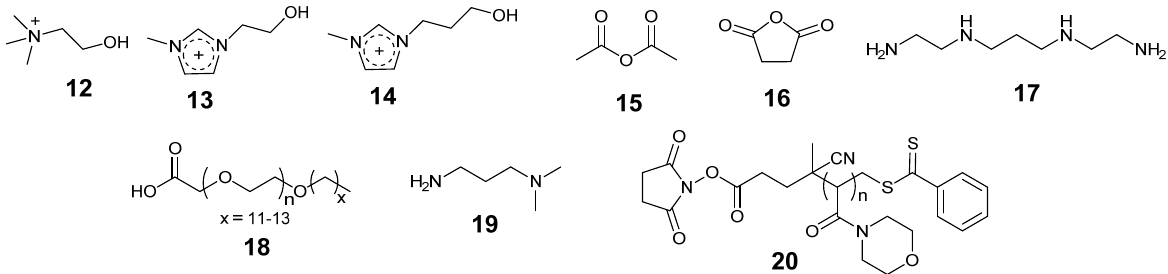
Figure 7. Chemical structure of some ionic liquid cations and modifiers ( 12 – 20 ) used to modify enzymes. Capping the protein surface by acetylation using 15 (Figure 7) or succinylation